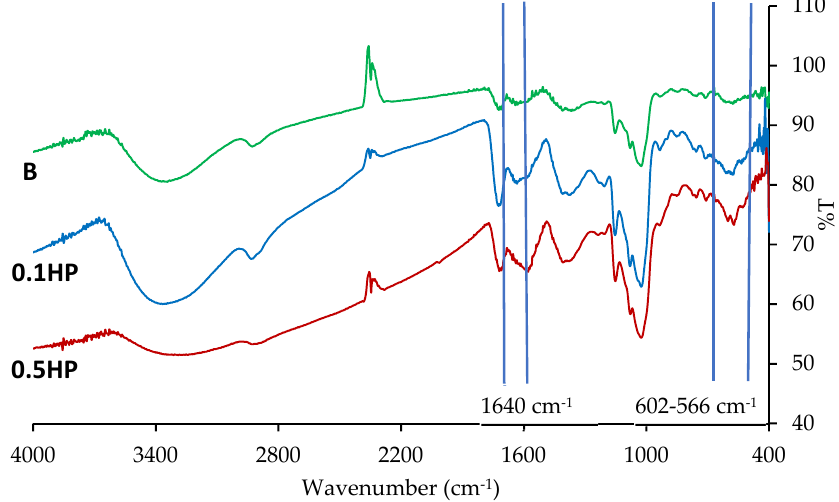
Figure 5. FT-IR profiles of the blank, 0.1 HP, and 0.5 HP scaffolds after cross-linking.